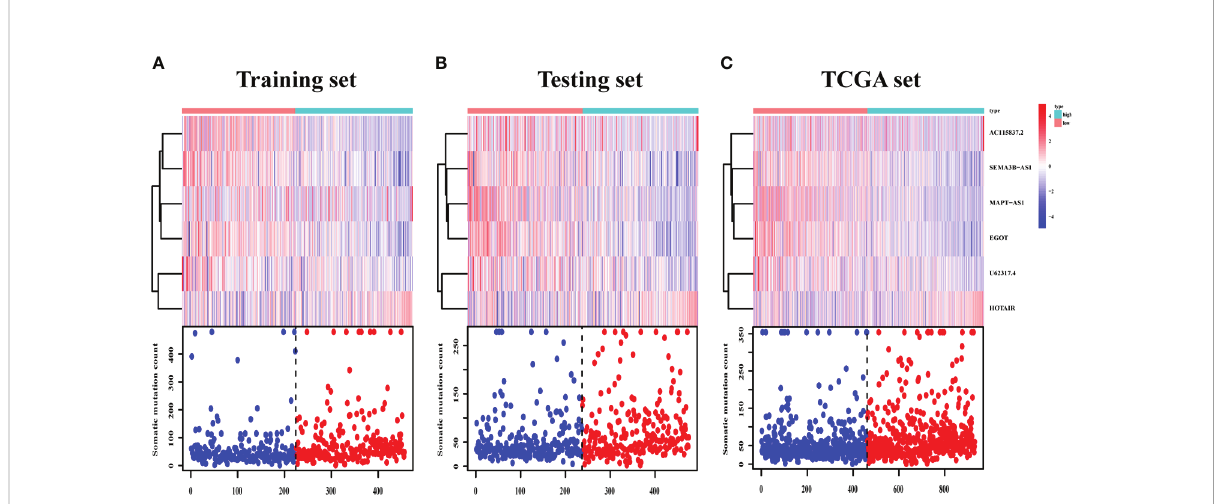
FIGURE 6 LncRNA expression and IDO1/TDO2 expression difference between patients with a high and low risk. LncRNA expression patterns and the distribution of somatic mutation counts in the training set (A) , testing set (B) , and TCGA set (C) with increasing risk score. TCGA, The Cancer Genome